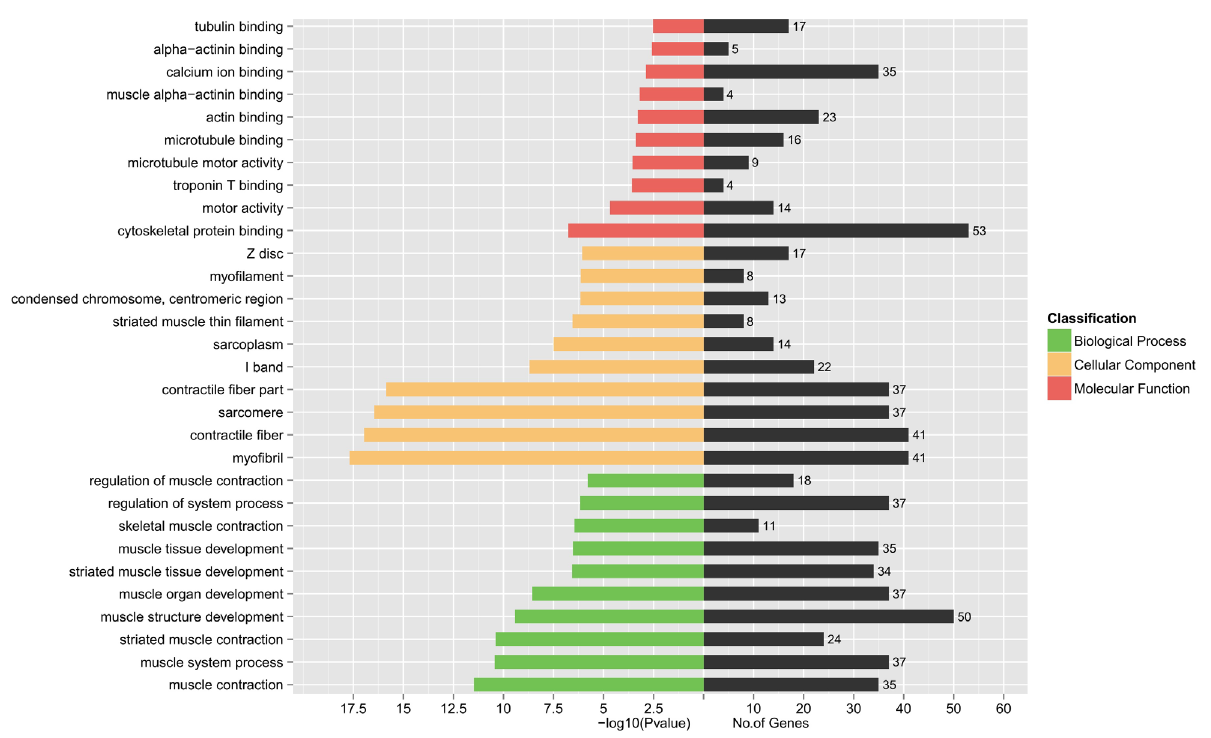
Figure 2: Differentially expressed mRNAs between the model group and the treatment group enriched in Top 10 Gene Ontology terms related to biological process, cellular component, and molecular